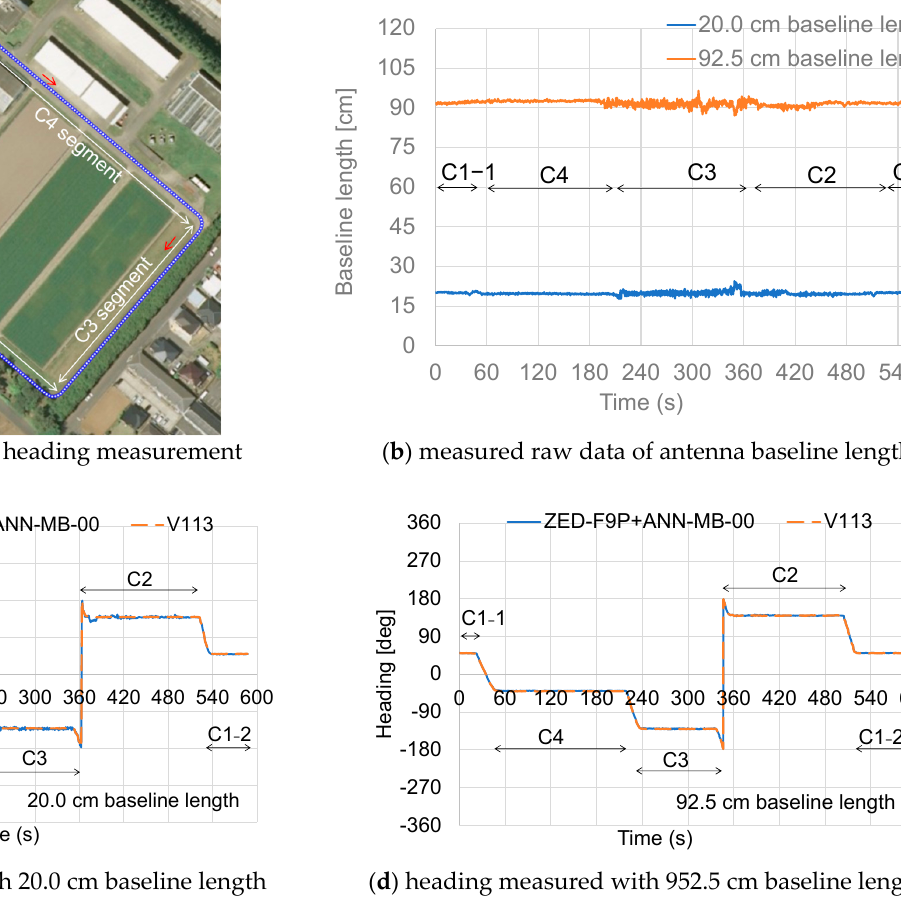
Figure 8. Measurement results of the heading of the carrier vehicle traveling on course C. Red arrows indicate traveling direction of the test carrier, while blue lines with white dots indicate the trajectory of the test carrier.